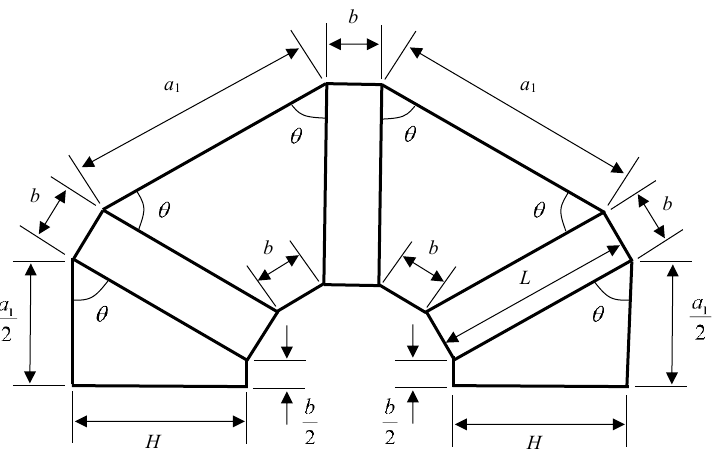
Figure 8. Basic shape and size of the truss core plane part. The flat part parameters are a 1 , b , H , L , and θ .